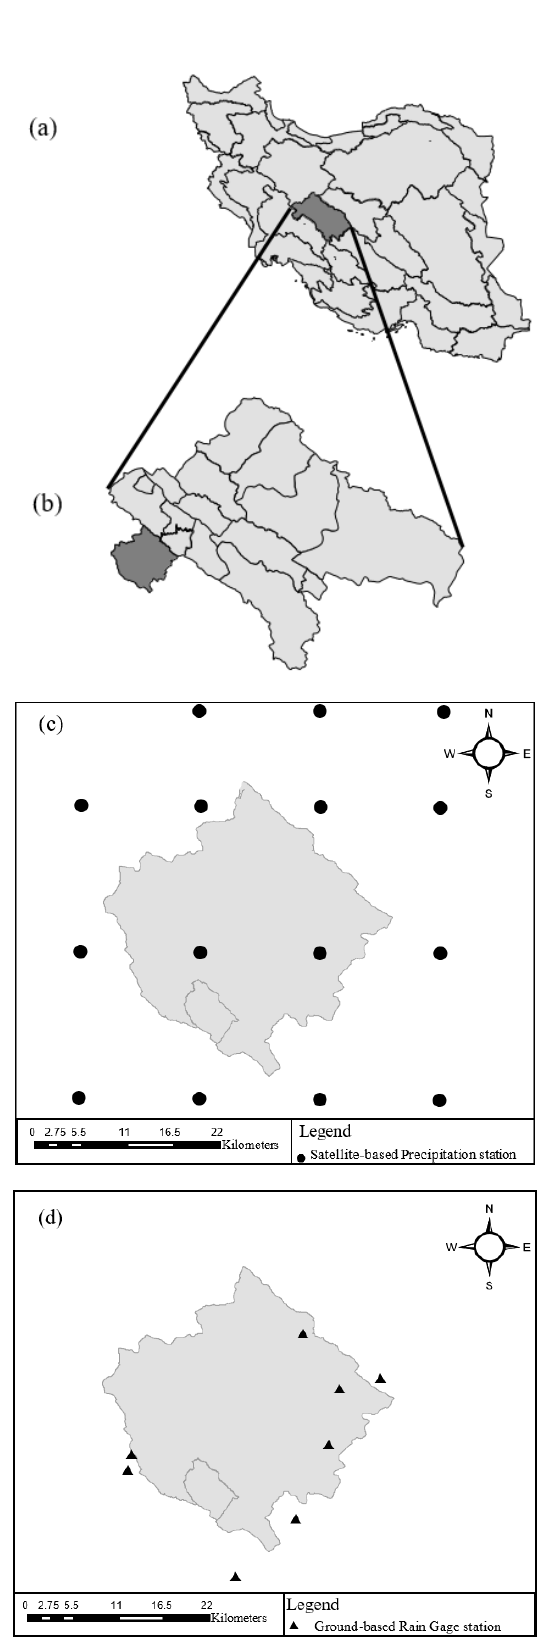
Figure 1. (a) Iran, (b) Zayandeh-Roud Basin, (c) Satellite-based Precipitation station (SPPs) locations in Chelgerd sub-basin, and (d) Ground-based Rain Gauge station (GRGs) locations Chelgerd